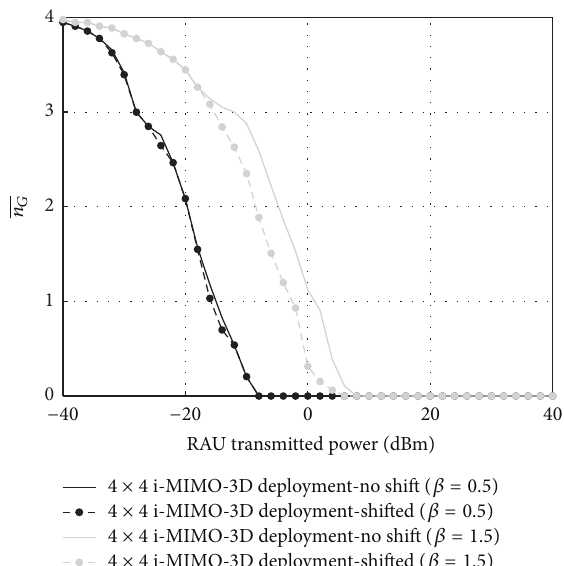
Figure 14: Performance comparison of 4 × 4 i-MIMO no-shift and diagonal-shifted 3D deployments. Average number of branches under threshold ( 𝑛 𝐺 ) is shown (RAU antenna horizontal distance: 20 m; RAU antenna vertical distance: 3 m; floor attenuation factor: